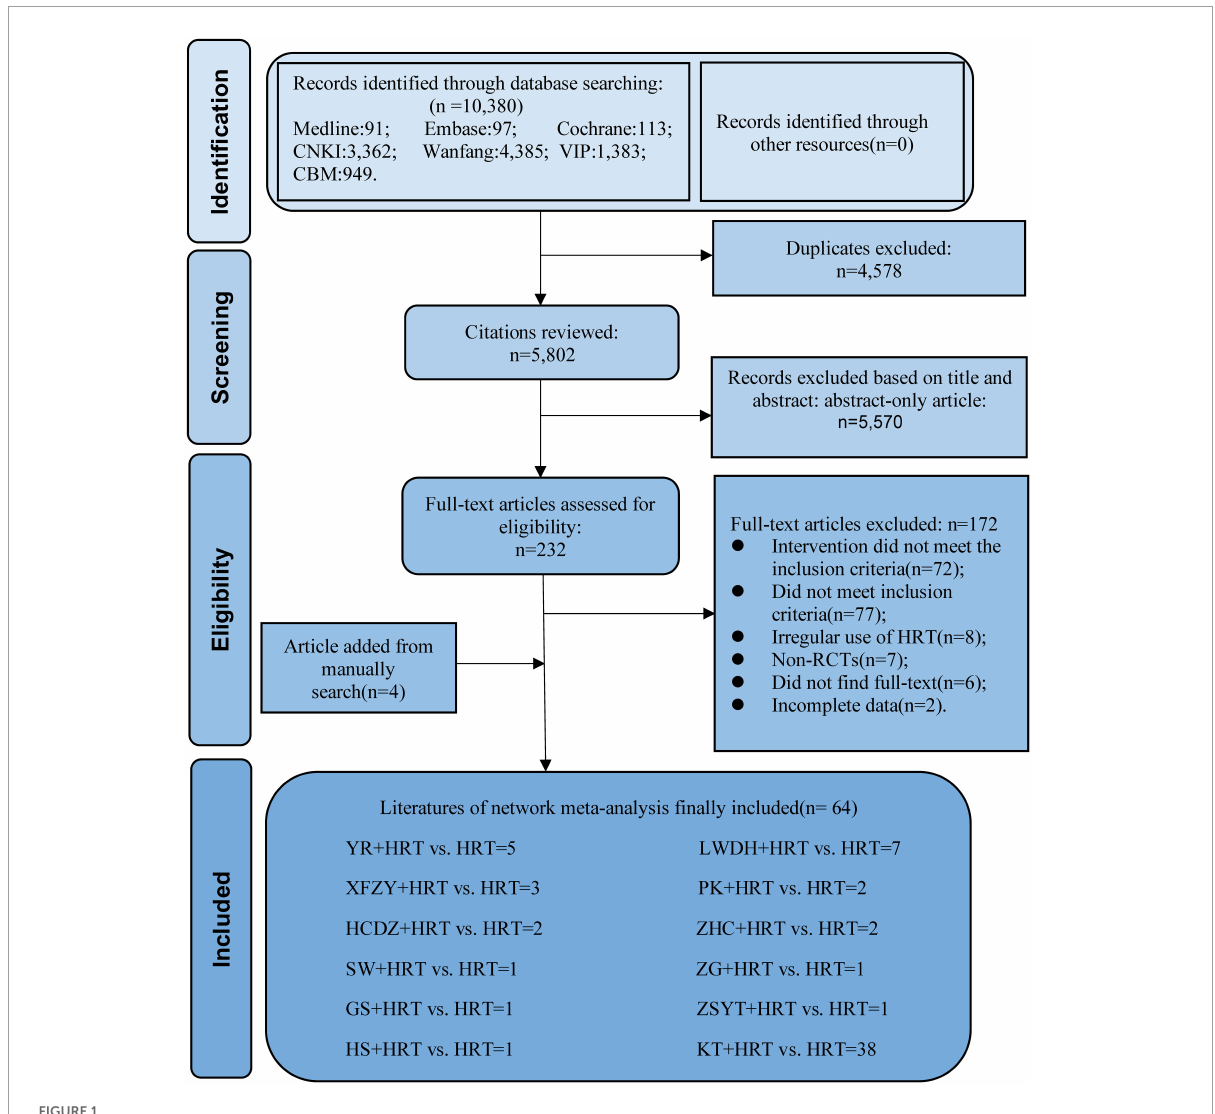
FIGURE1 Literature review